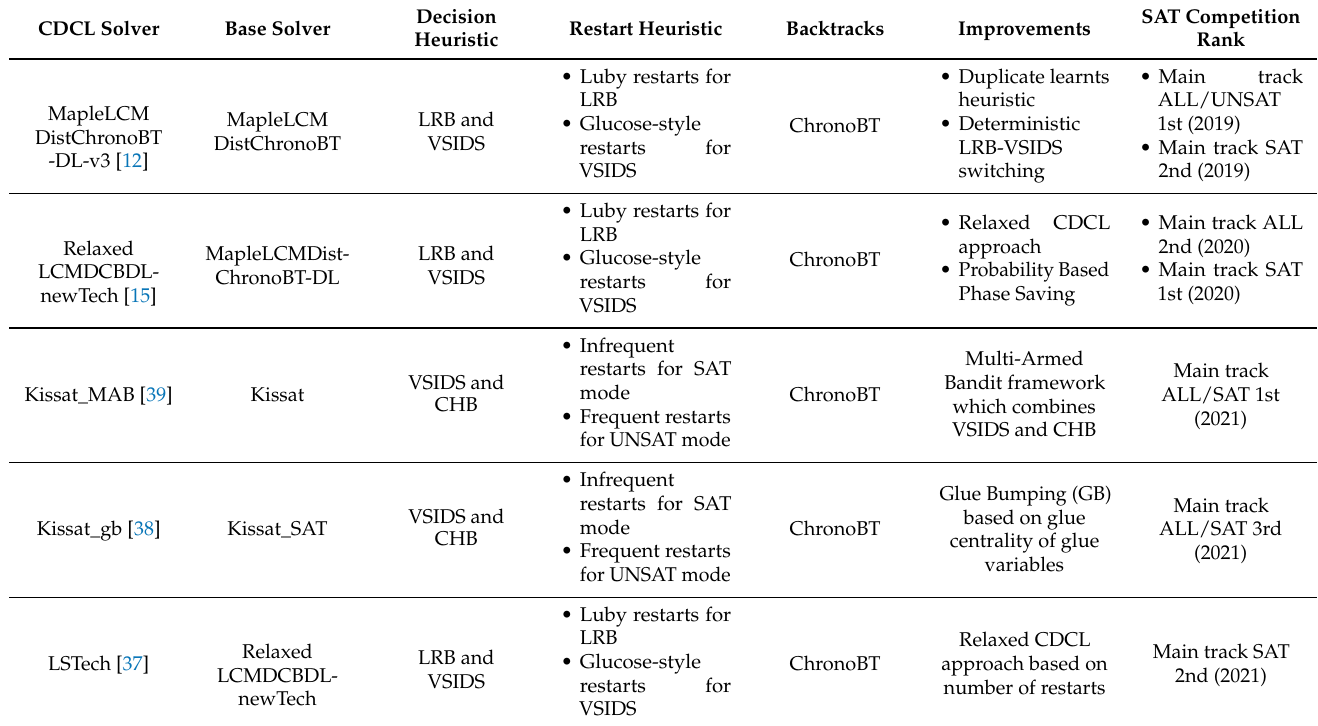
Table 1. The configuration of CDCL SAT solvers considered in this study. In the last column, under SAT competition rank, the SAT, UNSAT, or ALL indicate the type of track, which is either satisfiable, or unsatisfiable, or both,